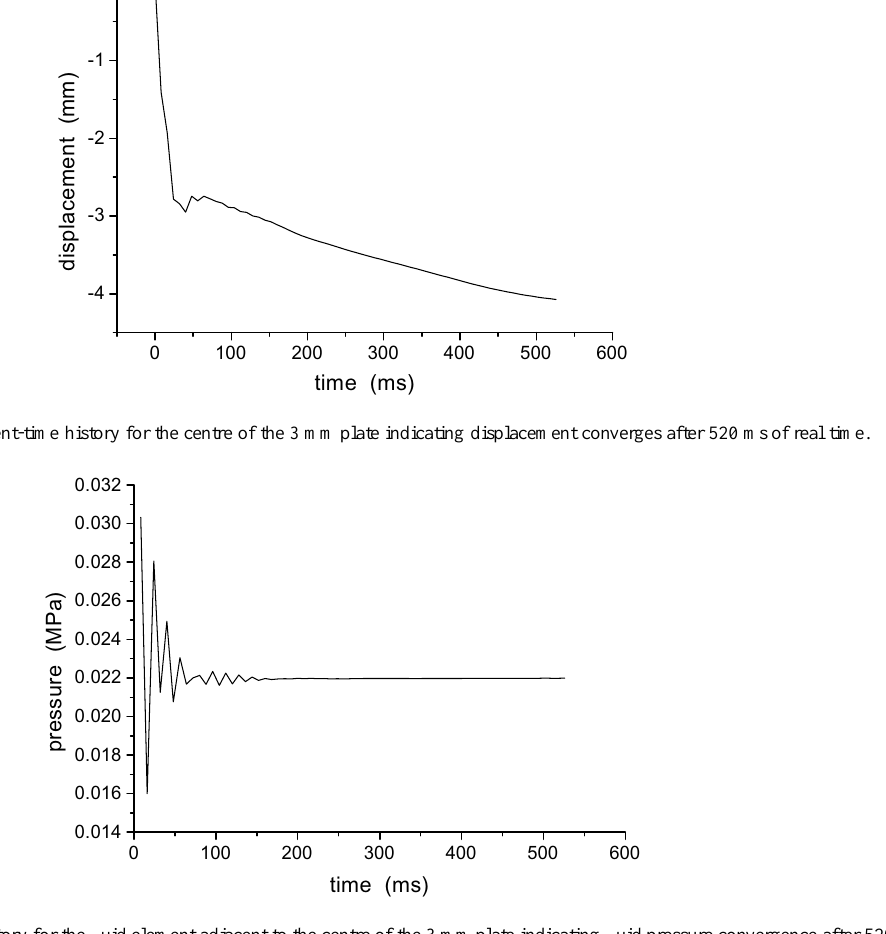
Fig. 4. The pressure-time history for the fluid element adjacent to the centre of the 3 mm plate indicating fluid pressure convergence after 520 ms of real time.